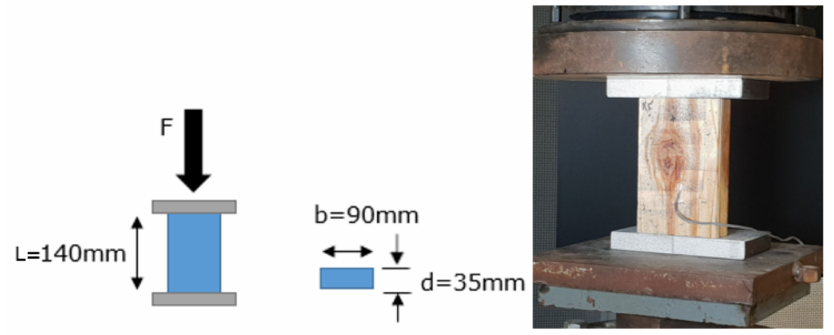
Figure 4. CParG test